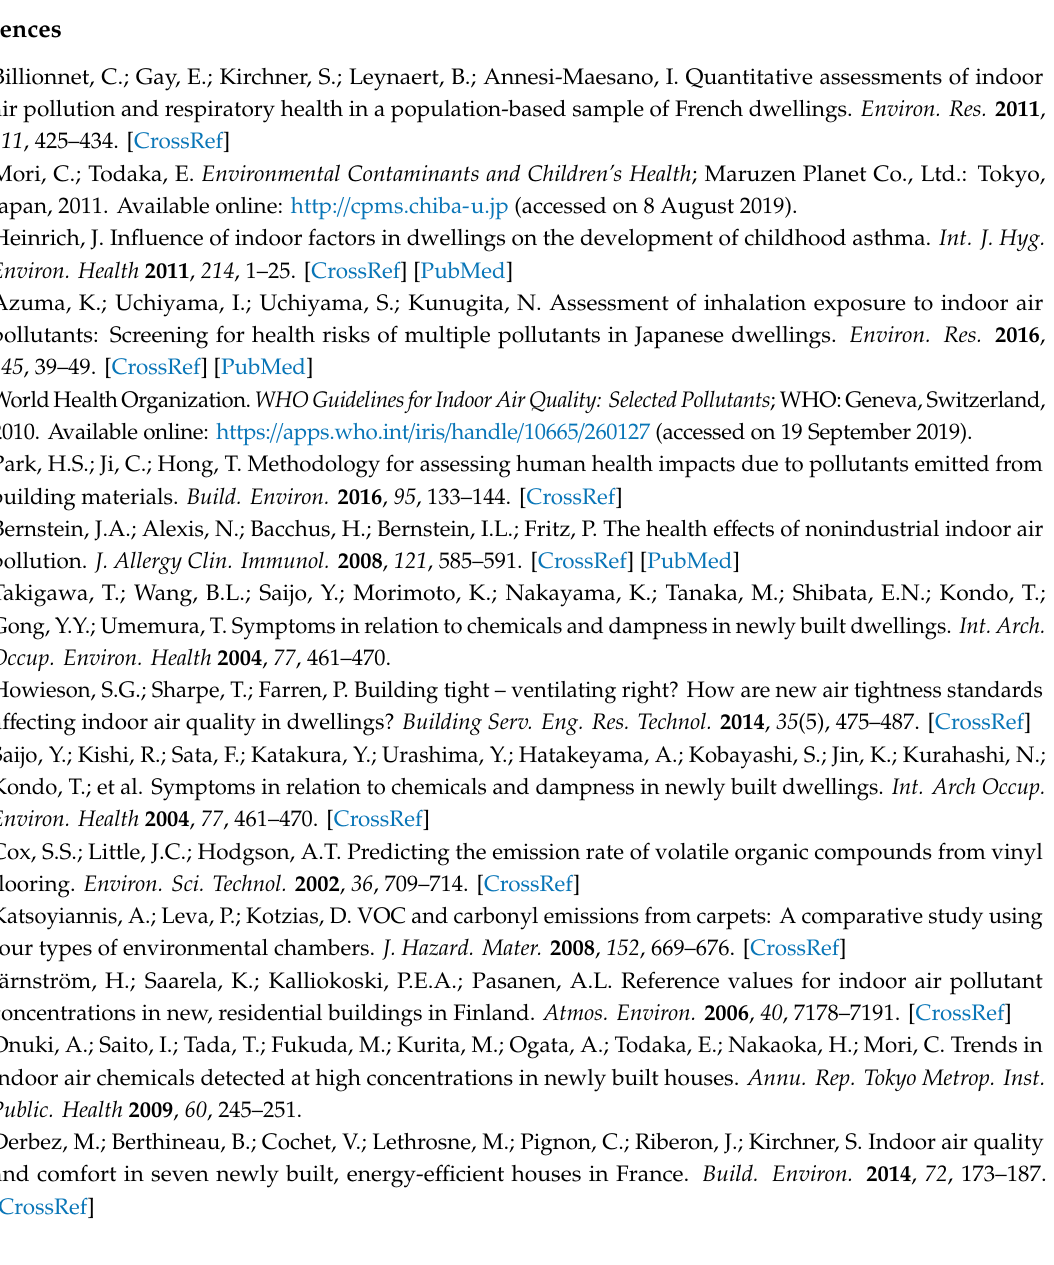
Table S1: VOC concentrations in the living rooms and bedrooms, Table S2: Carbonyl compounds in the living rooms and bedrooms, Table S3: SVOC concentrations in the living rooms and